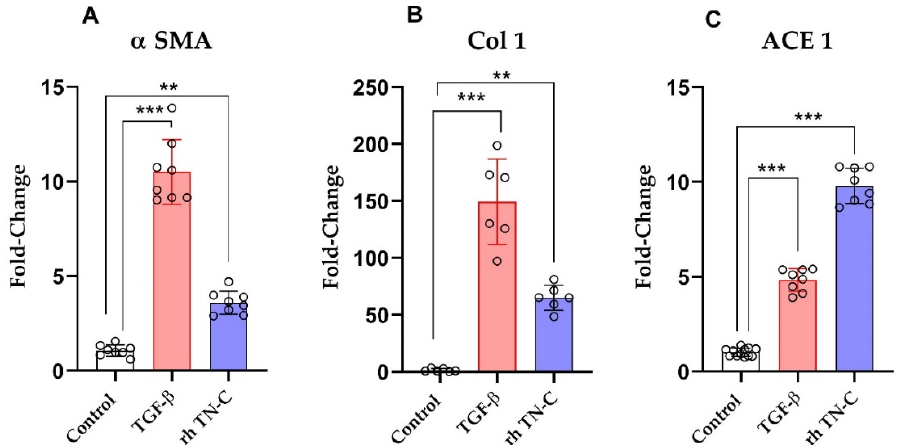
Figure 6. ( A ) Relative fold changes of mRNA expression of alpha-smooth muscle actin ( α -SMA), ( B ) collagen 1 (Col 1), and ( C ) angiotensin-converting enzyme (ACE) in human cardiac ventricular fibroblasts after 24 h of incubation with transforming growth factor beta (TGF- β ) or recombinant human tenascin-c (rh TN-C). ** p < 0.01, *** p < 0.001, n = 7–8 replicates/group.